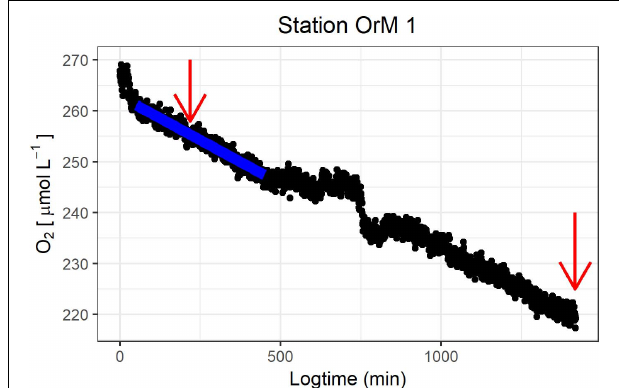
FIGURE 6 | Representative O 2 concentration series during a boxcore incubation (OrM 2), with the black dots representing the O 2 concentration ( µ mol L − 1 ) and the blue line the resulting linear regression which was used to calculate the O 2 flux. The red arrows indicate sampling of DIN. The disturbance caused by air bubble development is visible between minute 500 and 800. Plot produced with R package ggplot2 (Wickham, 2016).